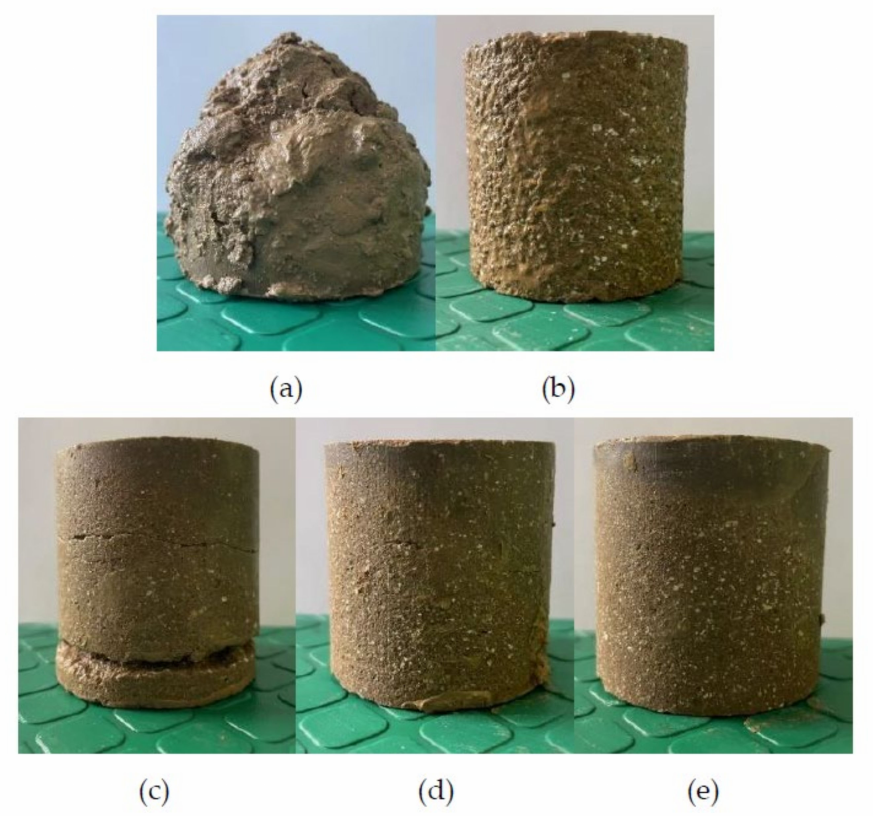
Figure 5. Sample soaked in water: ( a ) untreated soil; ( b ) M6A8; ( c ) M8A8; ( d ) M10A8; ( e )